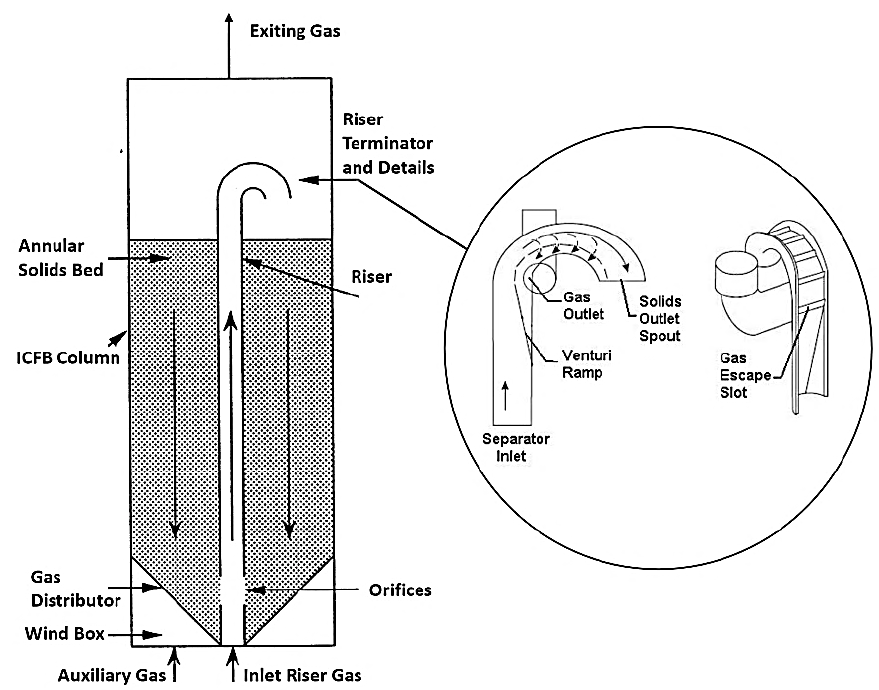
Figure 1. Internally circulating fluidized bed (ICFB) and riser terminator (adapted from [59,61]).